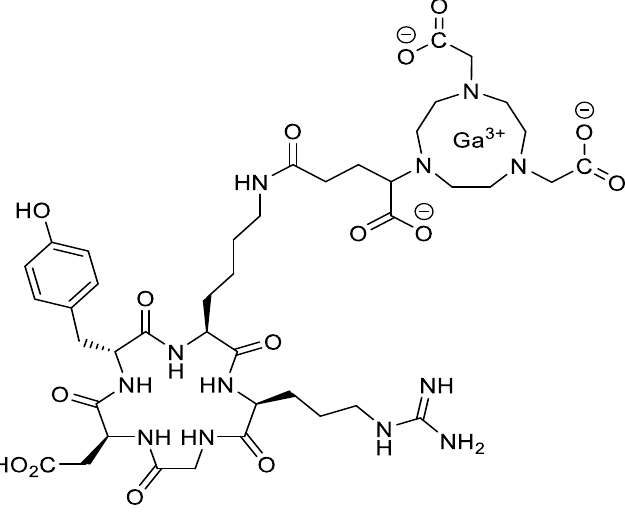
68 Figure 2. : Structure of [ 68 Ga]-NODAGA-RGD. Figure 2. Structure of [